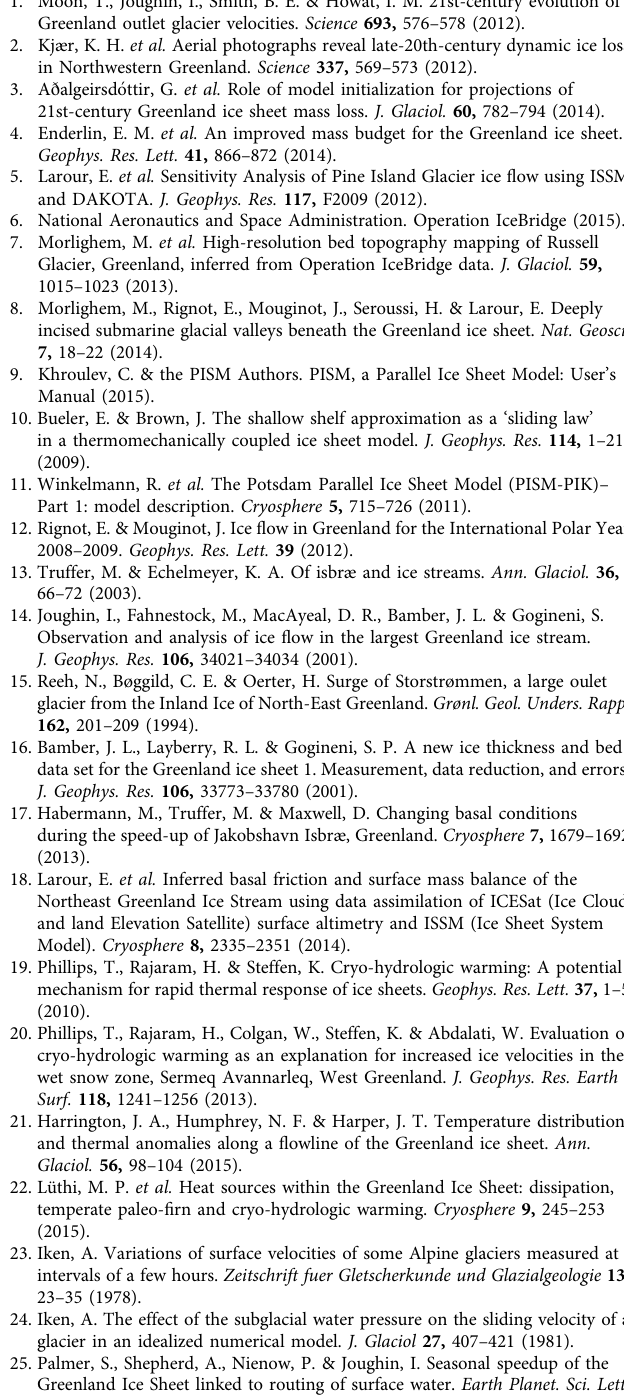
Supplementary Table 3. By this metric, Experiment 7 with ( q , n ) ¼ (0.6, 3.25) scores highest. Therefore, all subsequent simulations are performed with ( q , n ) ¼ (0.6,